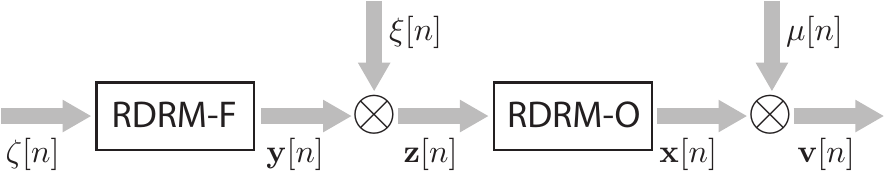
Figure 1. Structure of the